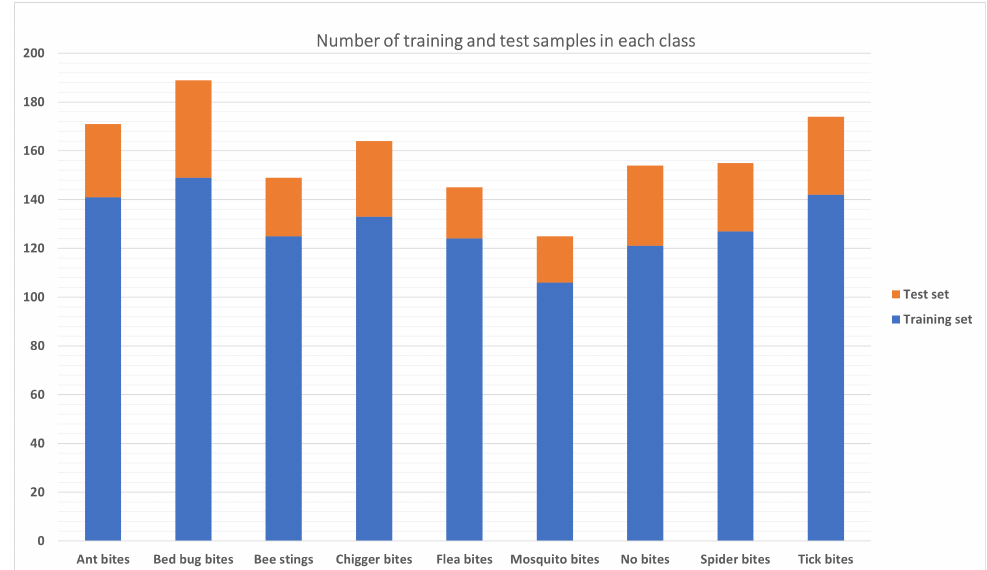
Figure 1. Ratio between the number of training and test samples per class.